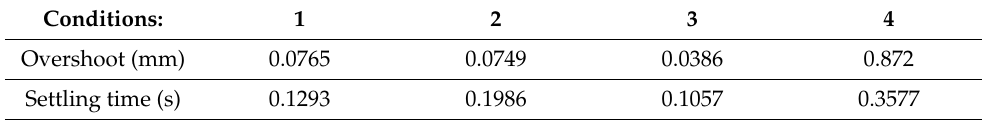
Table 4. Overshoot and settling time under each condition for reference.